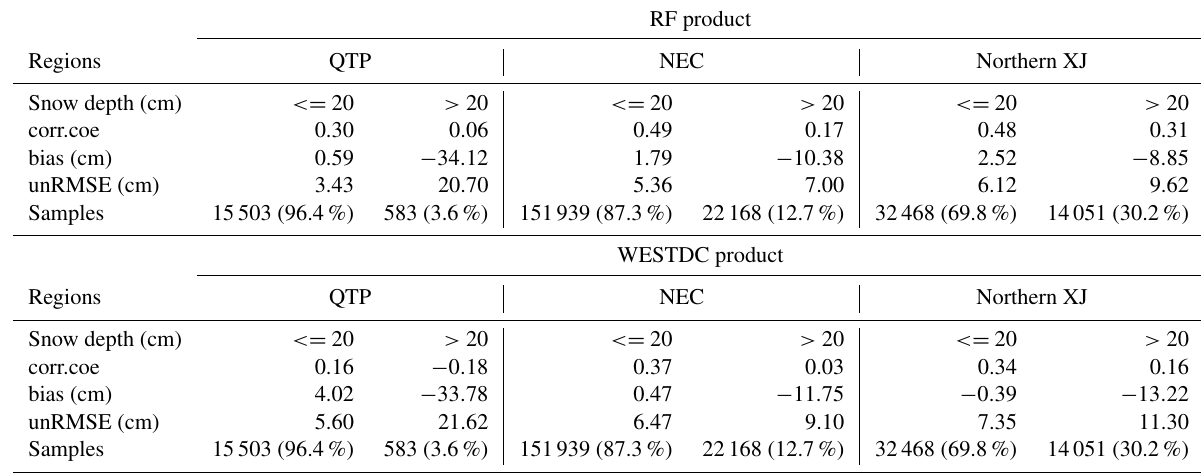
Table 5. Comparison between RF estimates and WESTDC product in three stable snow cover areas for deep ( > 20cm) and shallow ( ≤ 20cm) snow